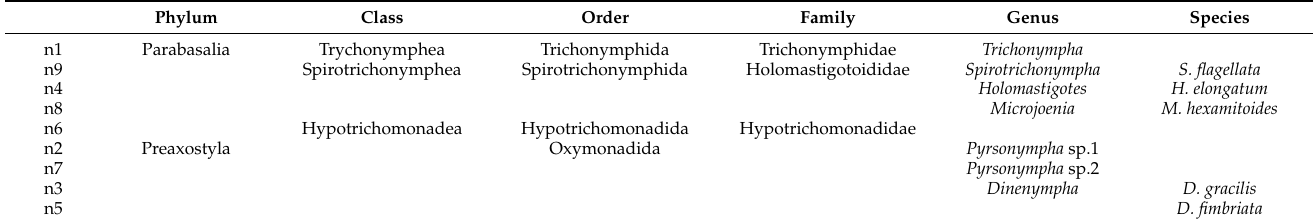
Table 3. Flagellate protist identification to morphotypes (n1 to n9) based on morphological characters. Phylum